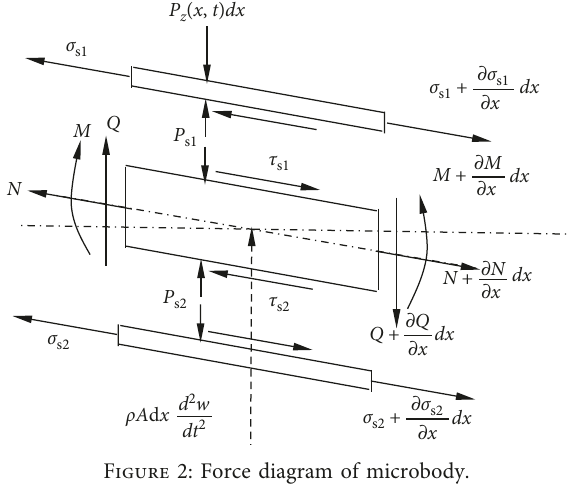
Figure 2: Force diagram of microbody.